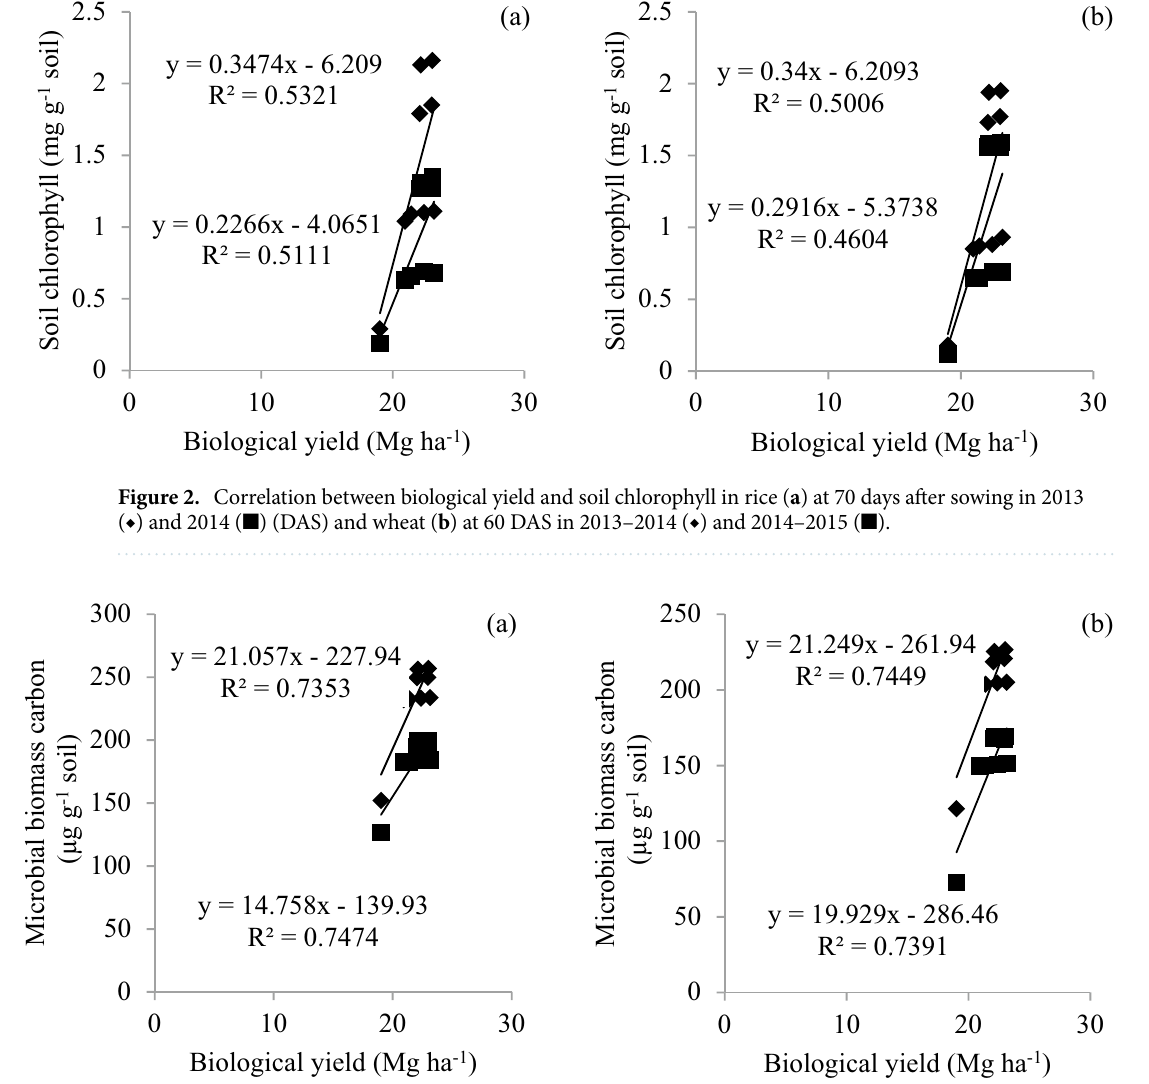
Figure 3. Correlation between biological yield and microbial biomass carbon in rice ( a ) at 70 days after sowing (DAS) in 2013 (◆) and 2014 ( ■ ) and wheat ( b ) at 60 DAS in 2013–2014 (◆) and 2014–2015 ( ■